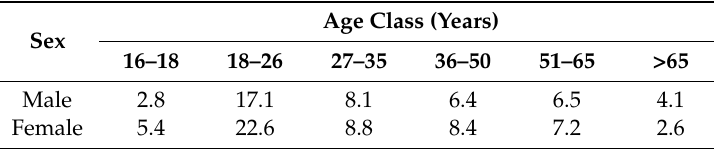
Table 1. Sample distribution (% of total) by sex and age classes.